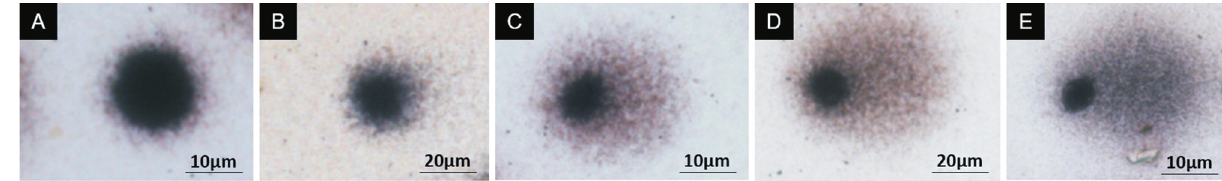
Figure 1 - Class of DNA damages (comet assay) observed in blood cells of C. macropomum in the three experimental groups: Group Without Injection (GWI), Group with corn oil injection (Sham); and Group with naphthalene injection (Naph) after 96 h normoxia exposure followed by 6 h of hypoxia.